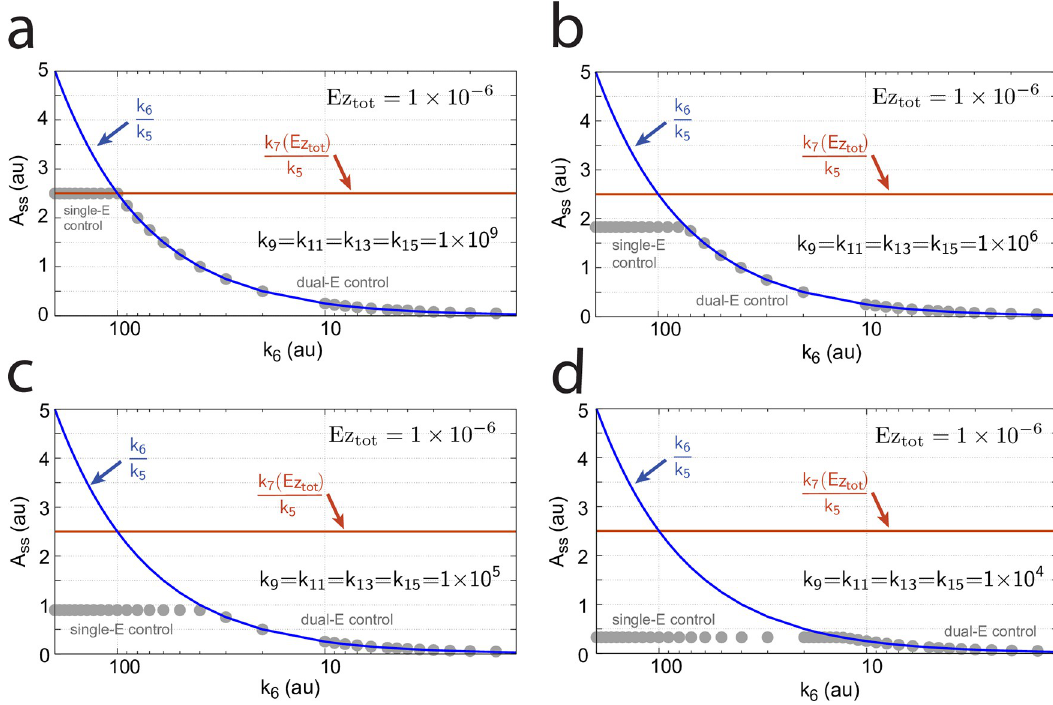
Fig 32. Switching between single-E control (Fig 31) and dual-E control (Fig 29) as a function of k 6 for different values of k 9 , k 11 , k 13 , and k 15 . Panel (a): high value (1 × 10 9 ) of k 9 , k 11 , k 13 , and k 15 . The dual-E controller shows its maximum operational range. In this case the switch occurs when k 6 > k 7 Ez . Panels (b)-(d): for the lower values of k 9 , k 11 , k 13 , and k 15 (indicated inside the figure) tot the ternary-complex concentration ( E 1 � Ez � E 2 ) is lower than Ez tot and the switch occurs at lower k 6 values, which leads to a decreased operational range of the dual-E controller. Due to the lower ( E 1 � Ez � E 2 ) concentration the single-E control mode (which occurs analogous to the red-outlined part in Fig 9e) shows an offset below k 7 Ez tot / k 5 . Note however, that A ss will depend on the perturbation k 1 and move towards A set with increasing k 1 , thereby reducing the single-E controller’s offset. Other rate constants: k 1 =500.0, k 2 =1.0,